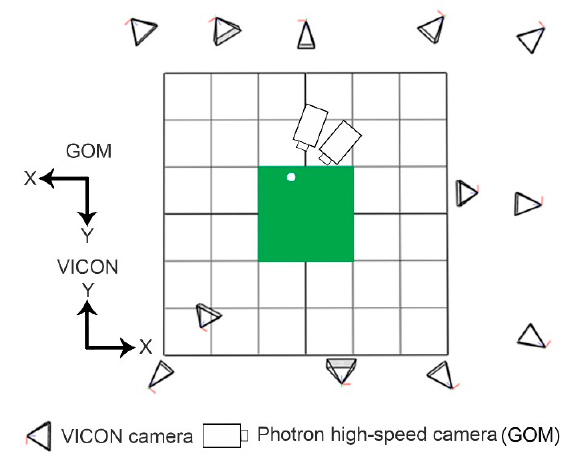
Figure 1. A schematic of the laboratory set-up used in the